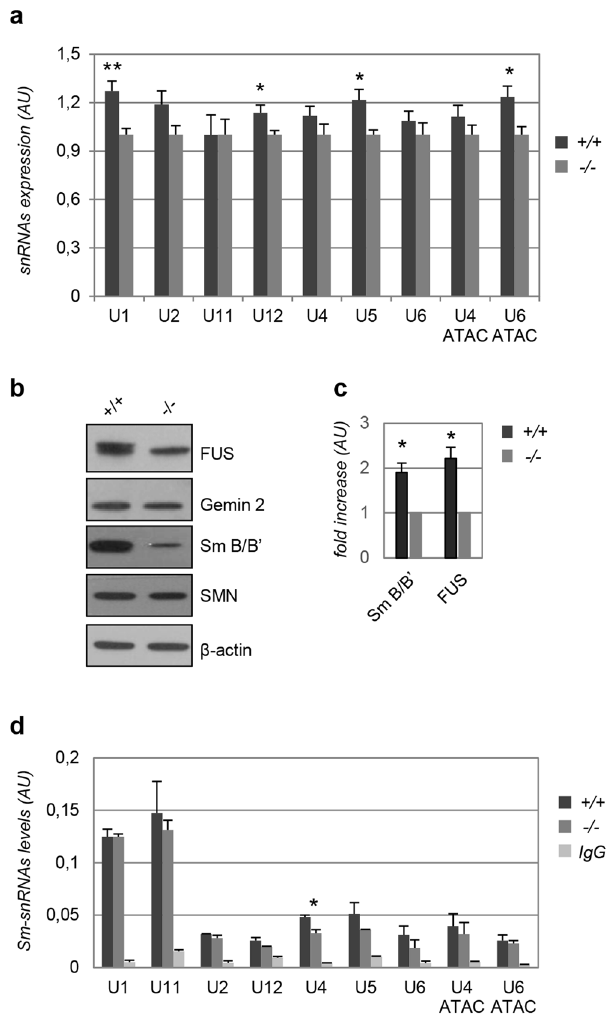
Figure 1. SnRNP composition and assembly in mice spinal cords are not significantly affected by hFUS overexpression. ( a ) RT-qPCR quantification of the indicated snRNAs in lysates from spinal cords of end-stage hFUS + / + mice. Means ± SE were normalized for the snRNA levels in control hFUS − / − mice. At least 6 animals for each genotype were used. Values significantly different from relative controls are indicated with an asterisk when P ≤ 0.05, and two asterisks when P ≤ 0.01. ( b ) Expression levels of Gemin2, Sm B/B’, SMN, FUS and β -actin were assayed by Western blot on spinal cord lysates from 40 days-old mice of the indicated genotypes. The panel is representative of at least n = 4 independent experiments. Full-length blots are presented in Supplementary Figure 6. ( c ) The expression levels of FUS (endogenous and exogenous) and Sm B/B’ in hFUS + / + mice were calculated by densitometric analysis of the bands from Western blots as in ( b ), normalised to β -actin levels and expressed as fold increases over the hFUS − / − control animals. Means ± SD are shown from n = 4 independent experiments. Values significantly different from relative controls are indicated with an asterisk when P ≤ 0.05. ( d ) RT-qPCR quantification of snRNAs in the Y12 anti-Sm immunoprecipitates from extracts of hFUS − / − and hFUS + / + mice. Unrelated IgGs were used in control immunoprecipitates. Values were normalized for the RNA in the input extracts and are reported as mean ± SD. Values significantly different from relative controls are indicated with an asterisk when P ≤ 0.05, and two asterisks when P ≤